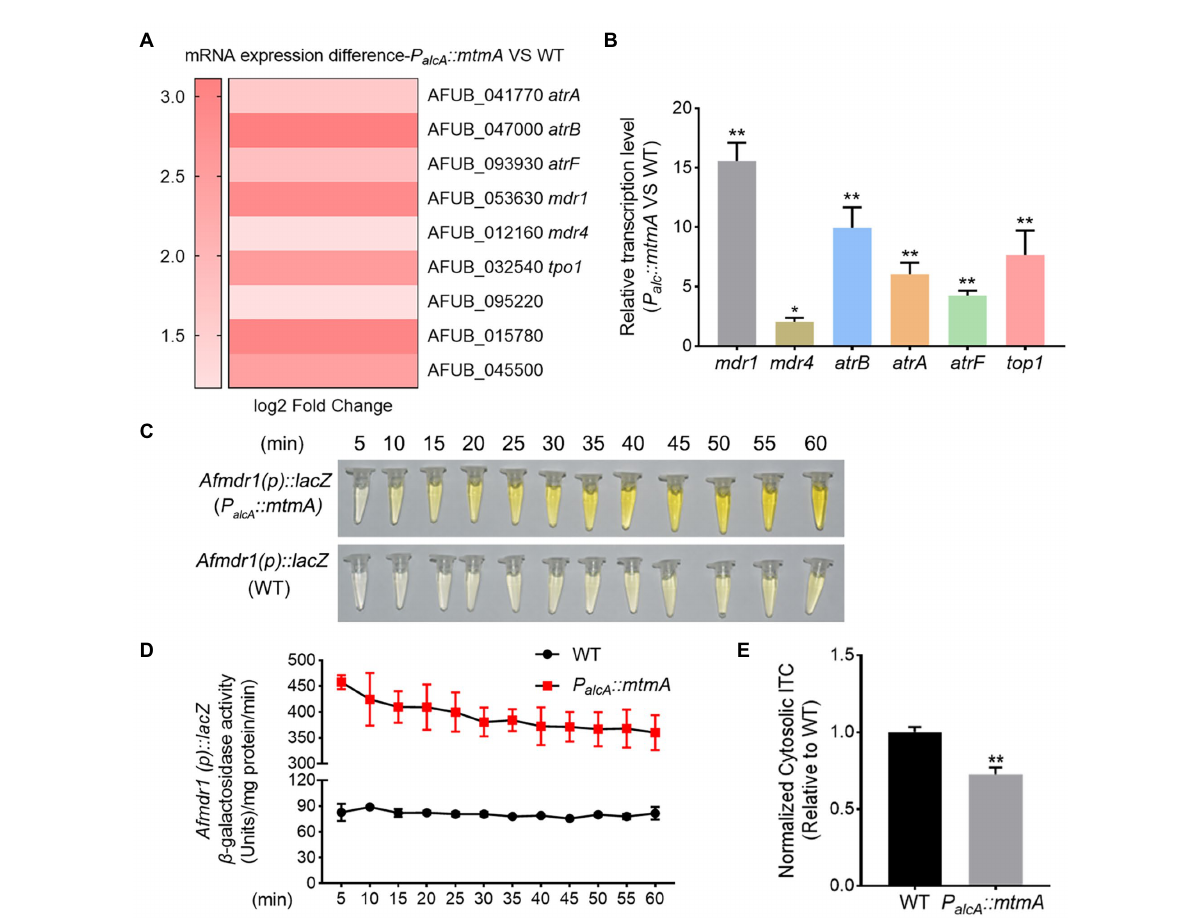
FIGURE 3 Repressed expression of MtmA induces upregulation of a series of drug resistance-related transport genes. (A) Heatmap of RNA-seq data for the 9 selected genes. (B) The transcript levels of the indicated genes in WT and the mtmA -repressed strains grown at 37 ° C for 24 h. Error bars indicate the mean ± SD of the results from three independent experiments. Statistical significance was determined by Student’s t test. *, p < 0.05; **, p < 0.01. (C,D) The transcript level of the multidrug-resistant transport gene mdr1 was confirmed by a β -galactosidase activity assay. Error bars indicate the mean ± SD of the results from three independent experiments. (E) The intracellular ITC concentrations in the indicated strains analyzed by HPLC. Normalized quantification and comparison of the ITC contents in WT and the mtmA -repressed strains. Values indicate the mean ± SD of the results from three independent experiments. **, p <